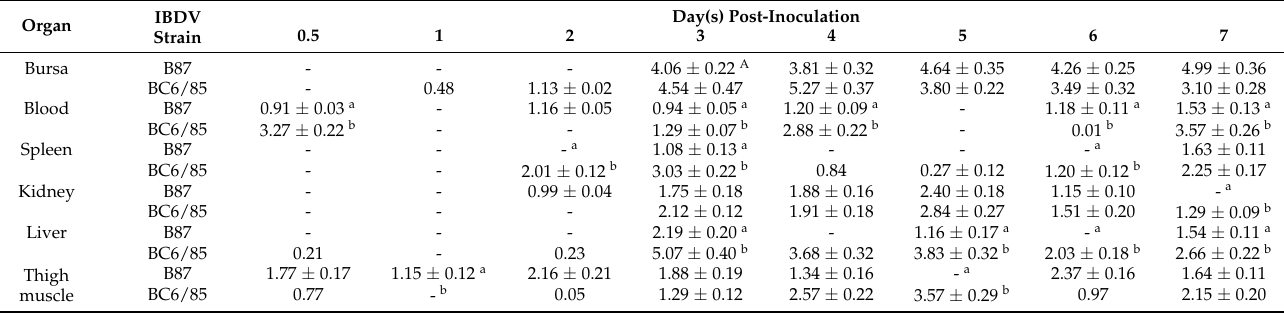
Table 4. Mean viral loads (log ELD 50 ) of Groups 1 and